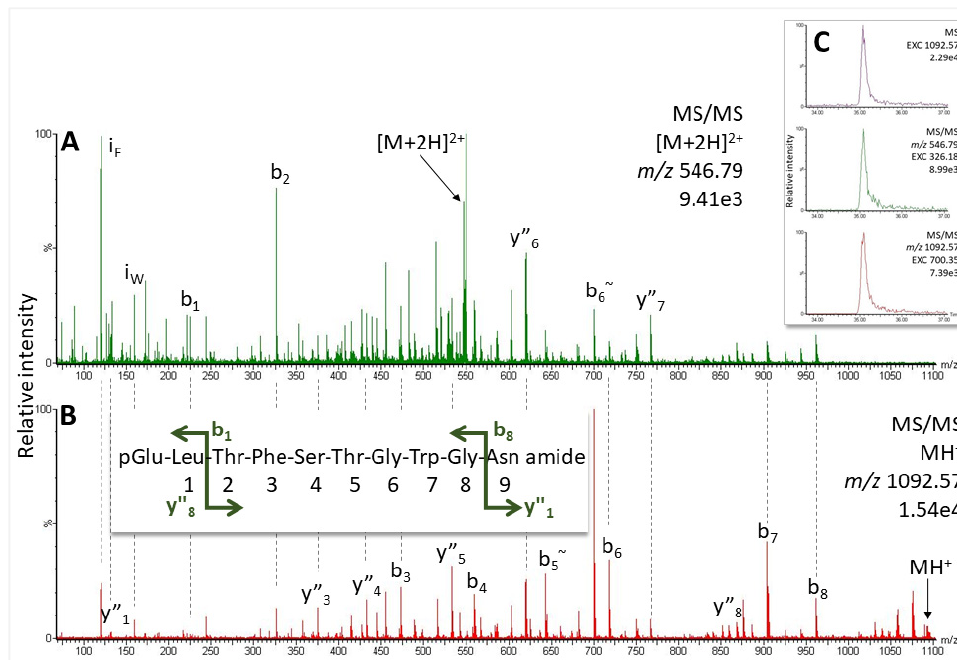
Figure 8. MS/MS spectra for the peptide assigned to Chipa-AKH in C. culmella of the ( A ) doubly- and